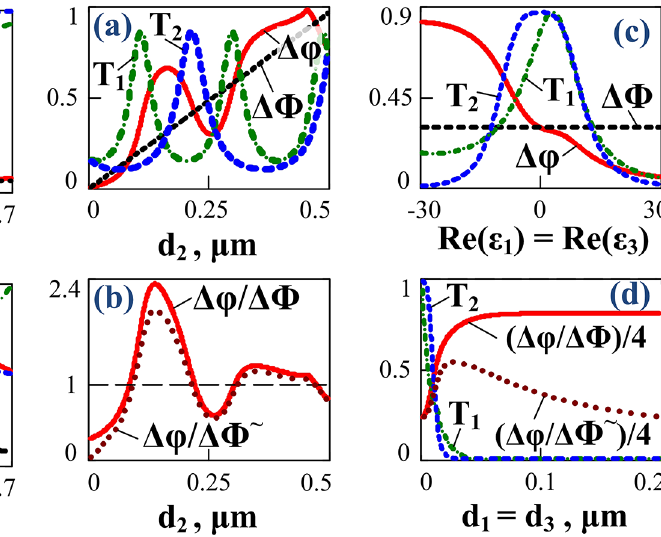
Fig. 5. Dependences of PSD D ’ , DF , relations D ’ / DF , D ’ / DF ∼ and energy transmission coef fi cients T 1,2 of waves 1, 2 on the main layer thickness d 2 (a, b), parameters e 0 (c), d 1,3 (d) for a metallic 1 ; 3 material of layers 1, 3. The values of parameters are: e 1 = e 3 = (cid:1) 13+ 0.5 i (a, b, d); d e 00 ¼ 0 : 5 (c). The values 2 =156 nm (c, d); 1 ; 3 of parameters for all the graphs are: d 1,3 = 13nm (besides d), l =0.6 m m. Figure b details the data in Figure a. The black horizontal dashed line in fi g. b characterizes equality to 1 of the corresponding